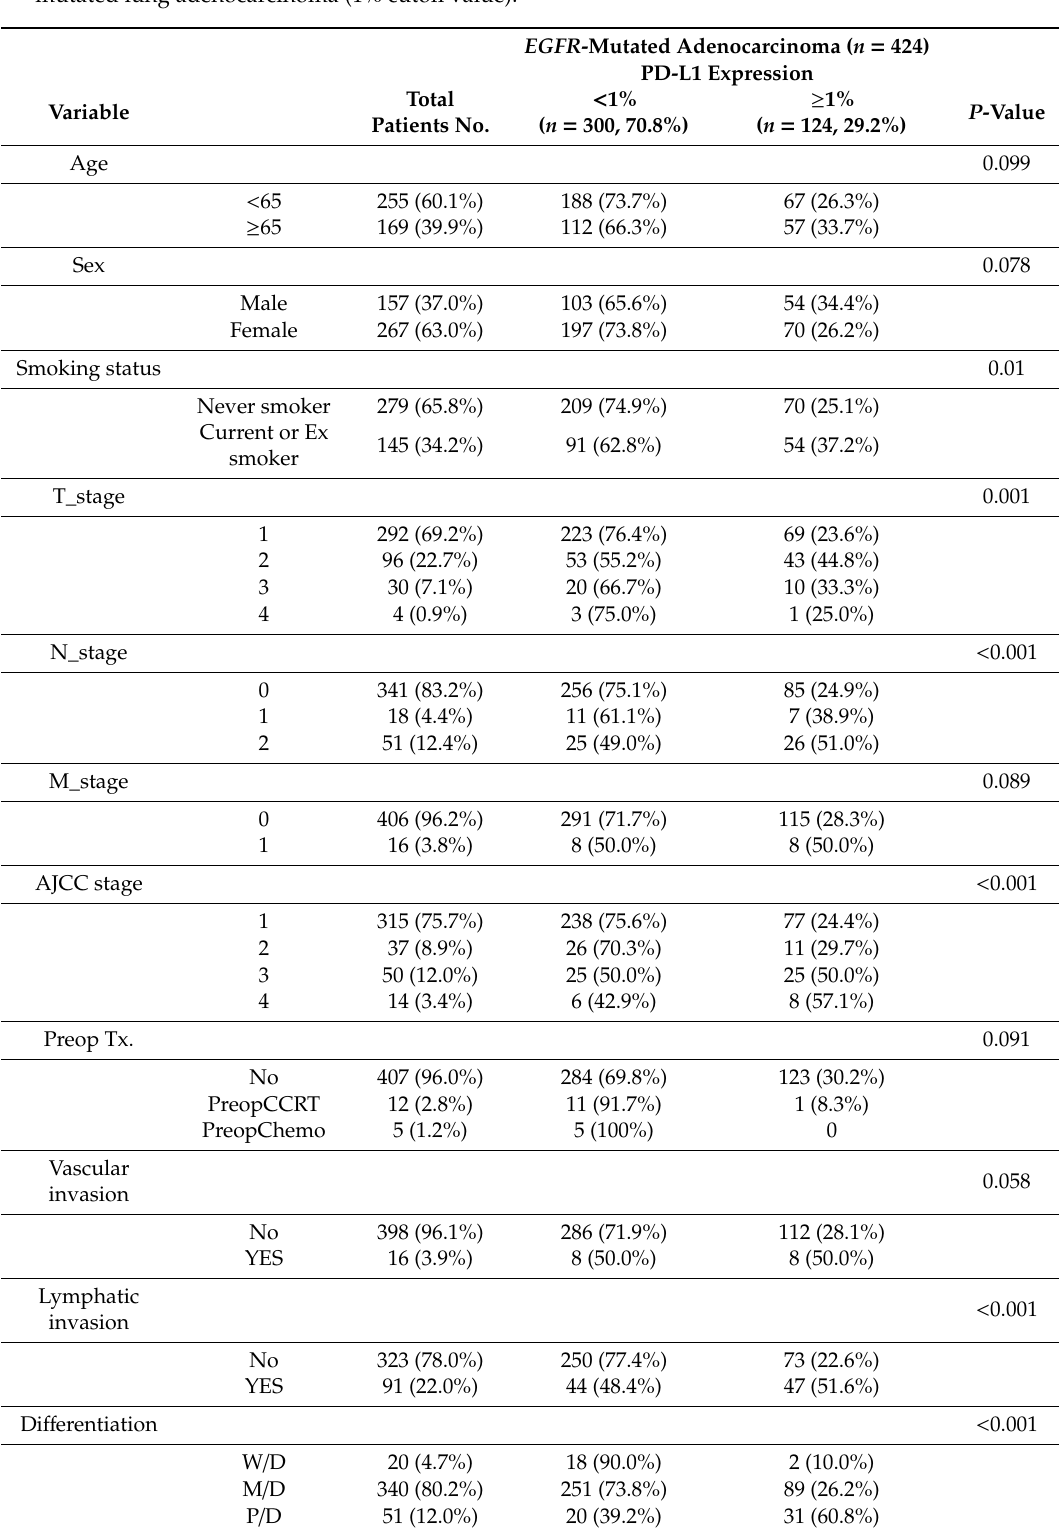
Table A4. Association between PD-L1 expression status and clinicopathological features in 424 EGFR mutated lung adenocarcinoma (1% cuto ff